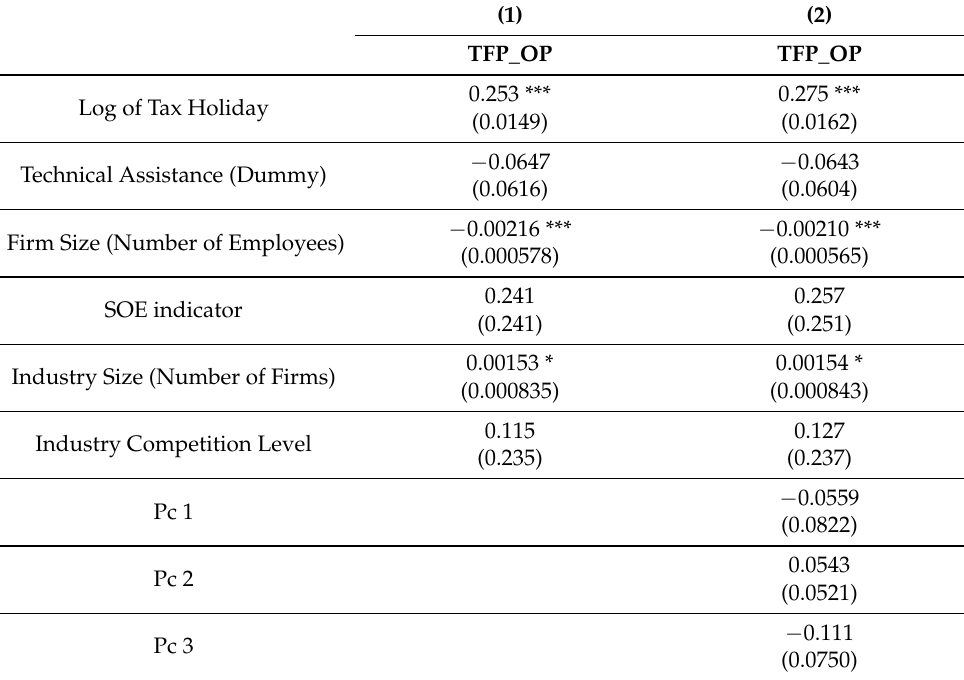
Table 10. Effects of Tax Holiday on Firm